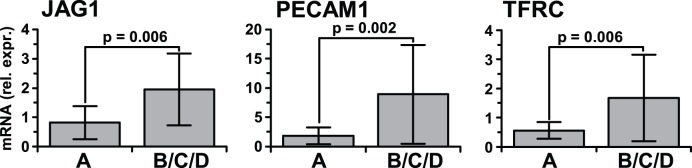
Increased endothelial cell type transcripts on the array.
JAG1, PECAM1 and TFRC are gene symbols for mRNAs that are expressed by brain endothelial cells predominantly. All three were significantly increased in Group C on the array. Confirmation with RT-PCR is shown. A, uninfected subjects (n = 6); B/C/D, HIV-1 infected subjects (n = 18). The increased expression of these endothelial transcripts was found to be present in the HIV-1 infected groups generally. mRNA is expressed relative to GAPDH mRNA. Mean ± SD, Student’s t test.